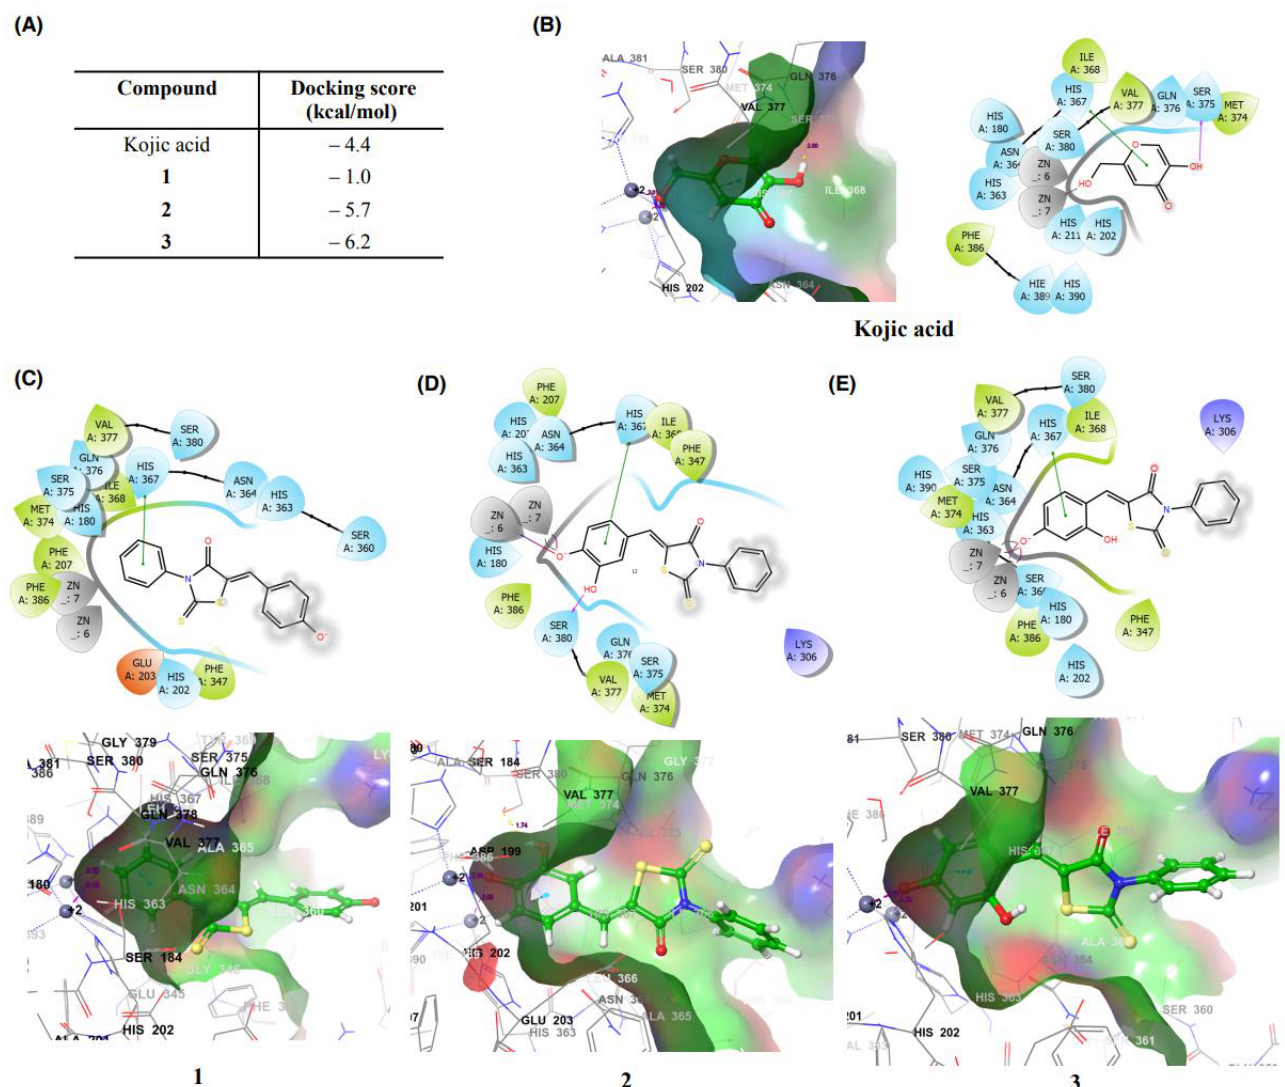
Figure 7. Docking scores ( A ) and expected binding interactions ( B – E ) of analogs 1 – 3 , and kojic acid determined using the h TYR homology model and Schrödinger Suite.